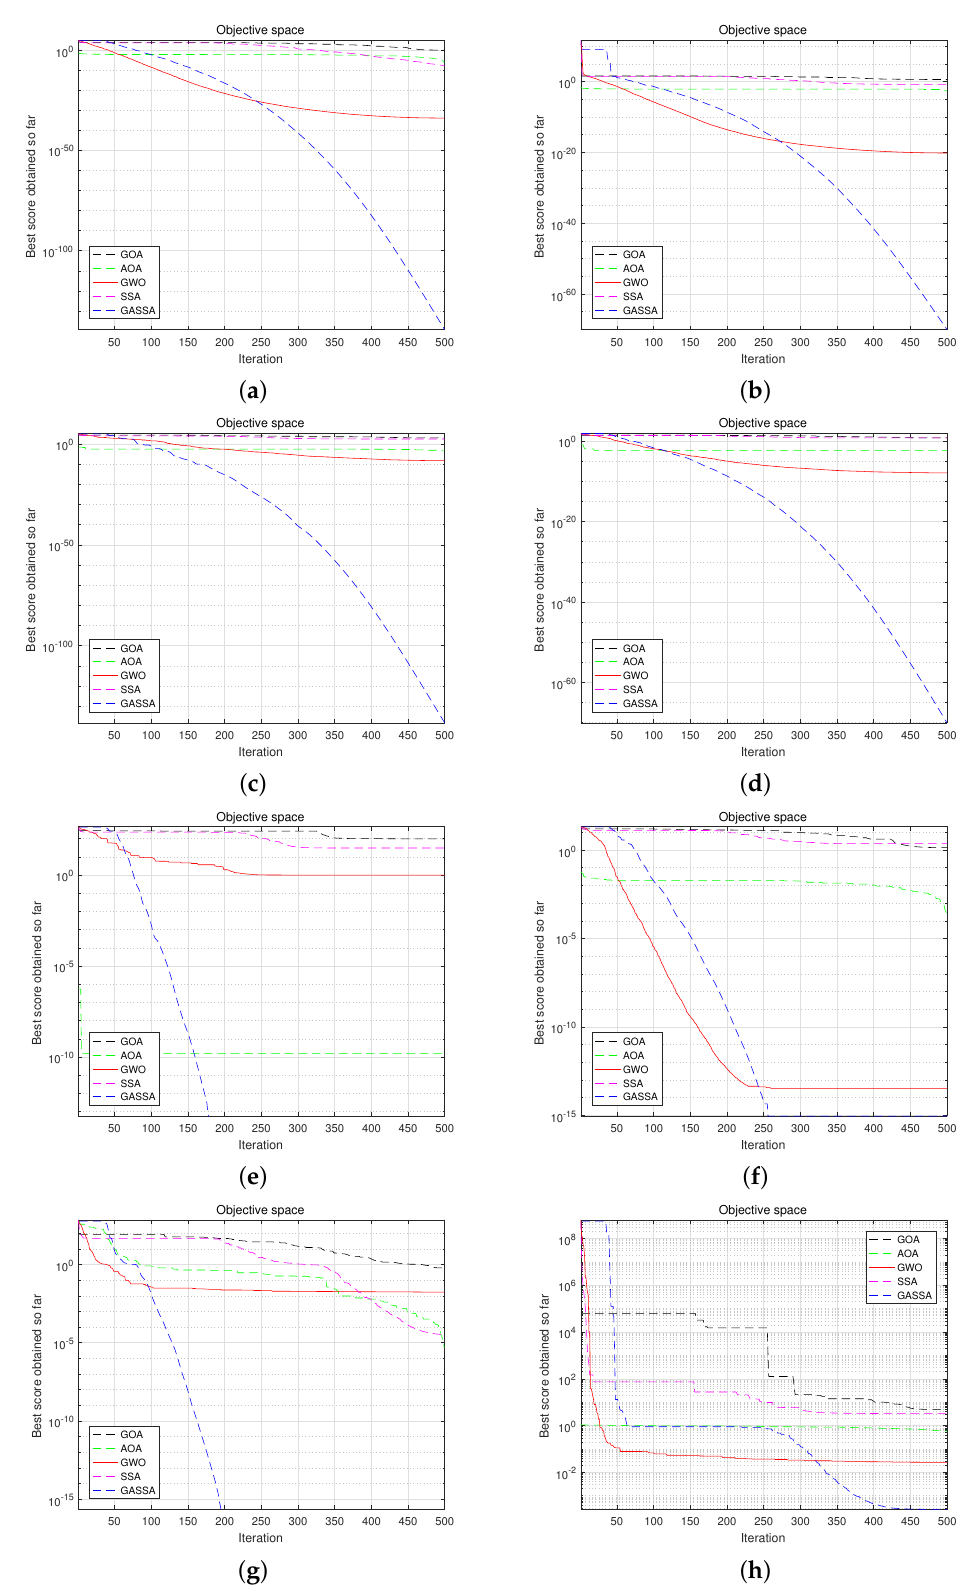
Figure 5. Convergence curve of benchmark functions. ( a) F 1 ; ( b ) F 2 ; ( c ) F 3 ; ( d ) F 4 ; ( e ) F 5 ; ( f ) F 6 ; ( g ) F 7 ; ( h ) F 8